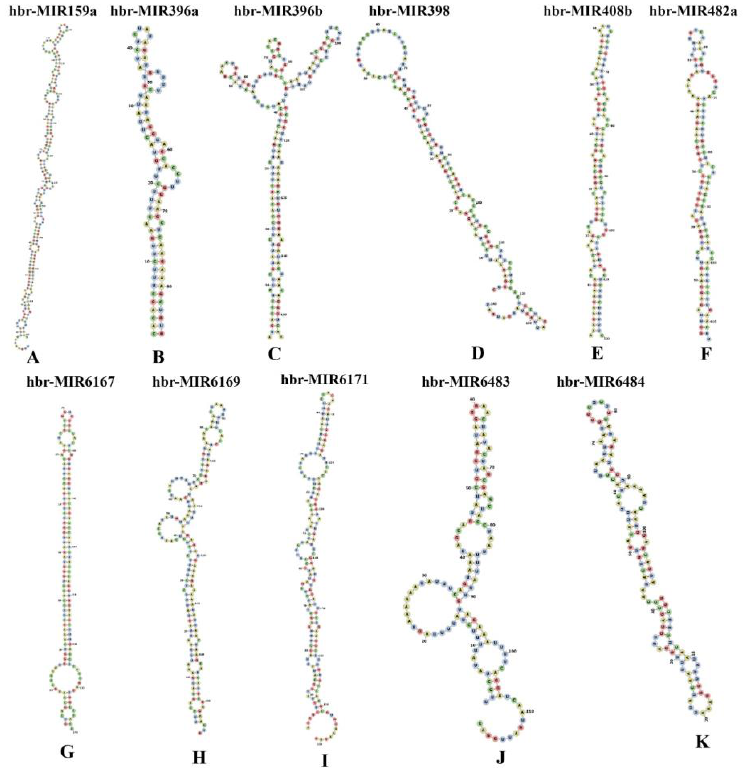
Figure 7. Stable secondary structures of eleven consensual precursors of the mature rubber tree miRNAs identified. Names with MFE are indicated: ( A ) hbr-MIR159a (−89.80 Kcal/mol), ( B )